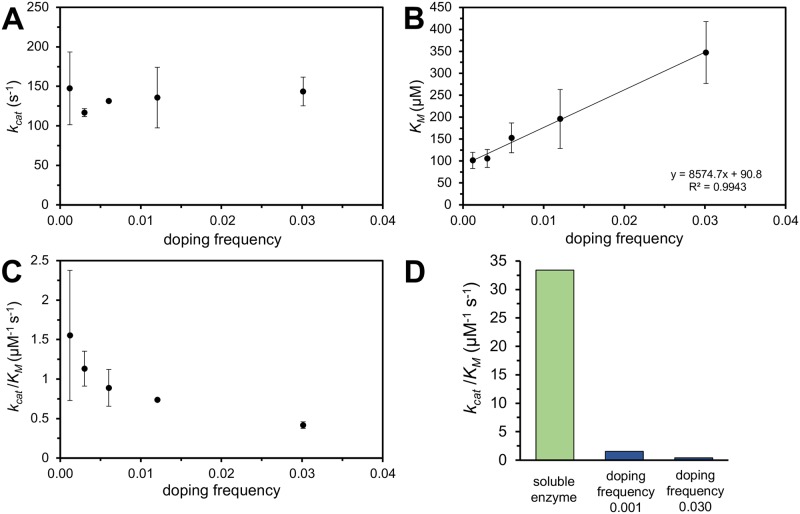
Kinetic constants kcat (A), KM (B) and kcat /KM (C) as a function of enzyme density on the fibril.This corresponds to a doping frequency of 1x10-3:1 to 30x10-3:1, with respect to the molar ratio of chimeric over carrier proteins. (D) Comparison of kcat /KM between the soluble TEM1-Ure2(1–80) (green) and the fibrils with a doping frequency of 1x10-3:1 and 30x10-3:1 (blue). All measurements were performed as triplicates.